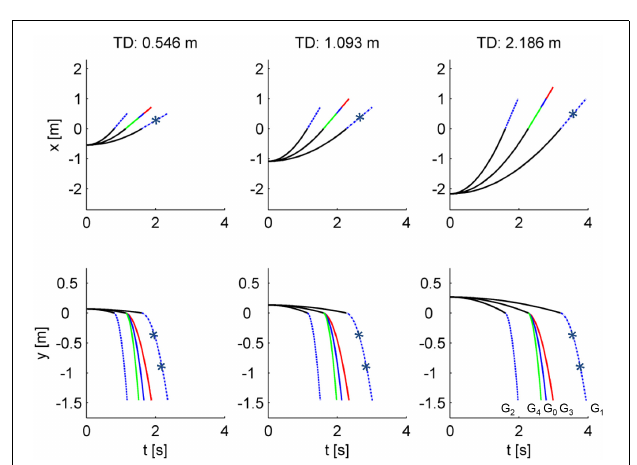
FIGURE 3 | Time course of ball motion for all experimental conditions. Time-varying trajectories of the center of ball mass in the horizontal and vertical direction are plotted in the top and bottom rows, respectively, from the starting position on the incline to the arrival time of the ball on the virtual floor. Black lines indicate the motion on the incline. Blue, red, and green lines indicate the trajectories in air for the internally consistent conditions (G 0 as continuous line, G 1 asterisk-dashed, G 2 dashed), the inconsistent condition G 3 , and the inconsistent condition G 4 , respectively. Each column corresponds to a different traveled distance (TD) on the incline.